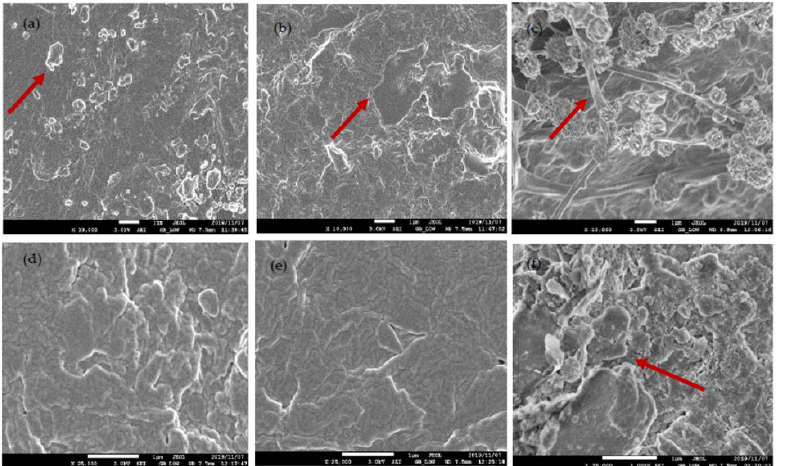
Figure 6. ( a ) SEM image of PBAT–PLA at day 0; ( b ) SEM image of PBAT–PLA after 30 days biodegradation; ( c ) SEM image of PBAT–PLA after 60 days of biodegradation; ( d ) SEM image of PBAT–PBS at day 0; ( e ) SEM image of PBAT–PBS after 30 days biodegradation; and ( f ) SEM image of PBAT–PBS after 60 days of biodegradation.